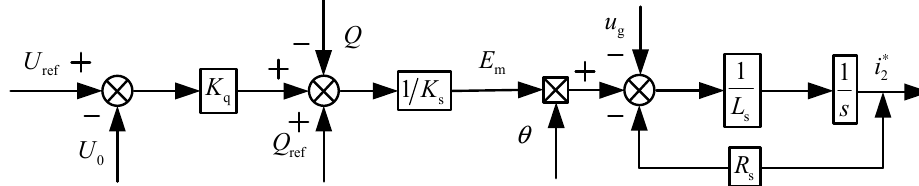
Q Figure 5. Control block diagram of synchronous generator excitation regulator. The reactive power–voltage control block diagram of the virtual synchronous gener-